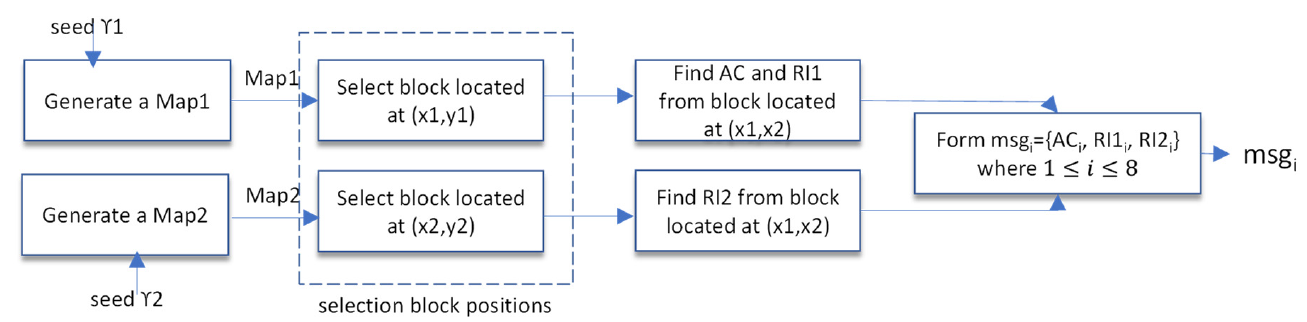
Figure 4. Process for selecting embedding block position and generating the hidden message AC and